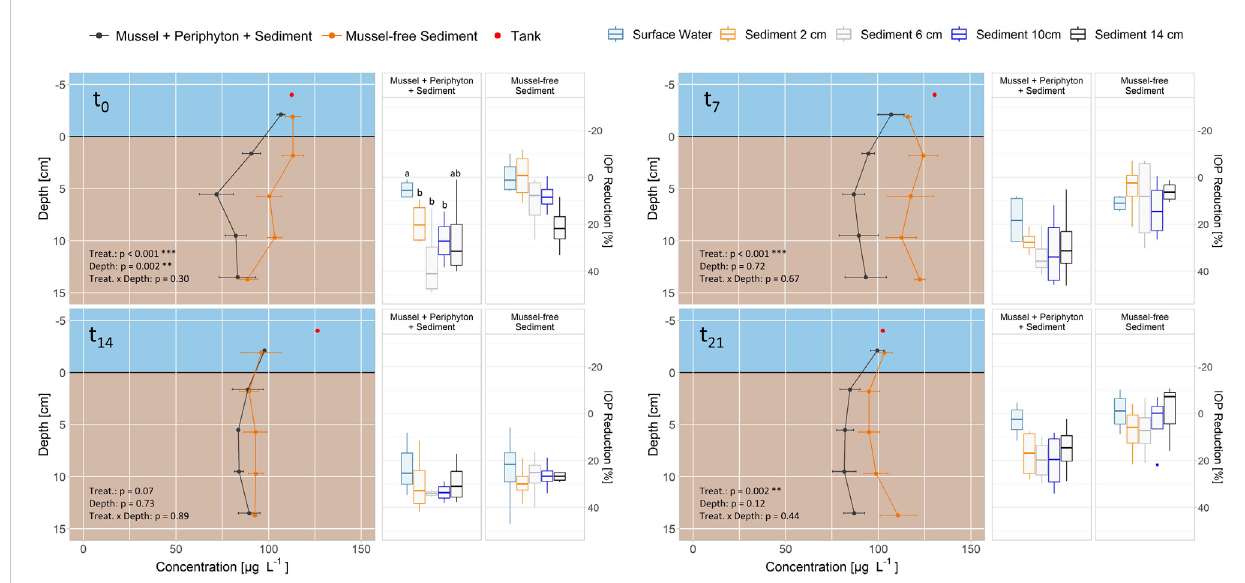
FIGURE 5 Removal of iopromide (IOP) in fl ow-through column Experiment 3 (mussels with periphyton and sediment)for 0, 7, 14 and 21 days (t 0 -t 21 ). Distance velocitythroughthecolumnsis0.25 m d -1 .Dataforconcentrationisshownasmeans±standarderror( n =4)andforreductionattheindividualdepthsin relation to the tank concentrations as boxplots ( n = 4), for mussels with periphyton and sediment (gray lines, left group of boxplots) and mussel-free sediment (orange lines, right group of boxplots). Different letters indicate signi fi cant differences for each timepoint at p < 0.05 (Kruskal-Wallis-Test with Wilcoxon Post-Hoc Test). Aligned Rank Transform (bottom left corner) shows signi fi cant differences for treatment (treat.), depth and their interaction.